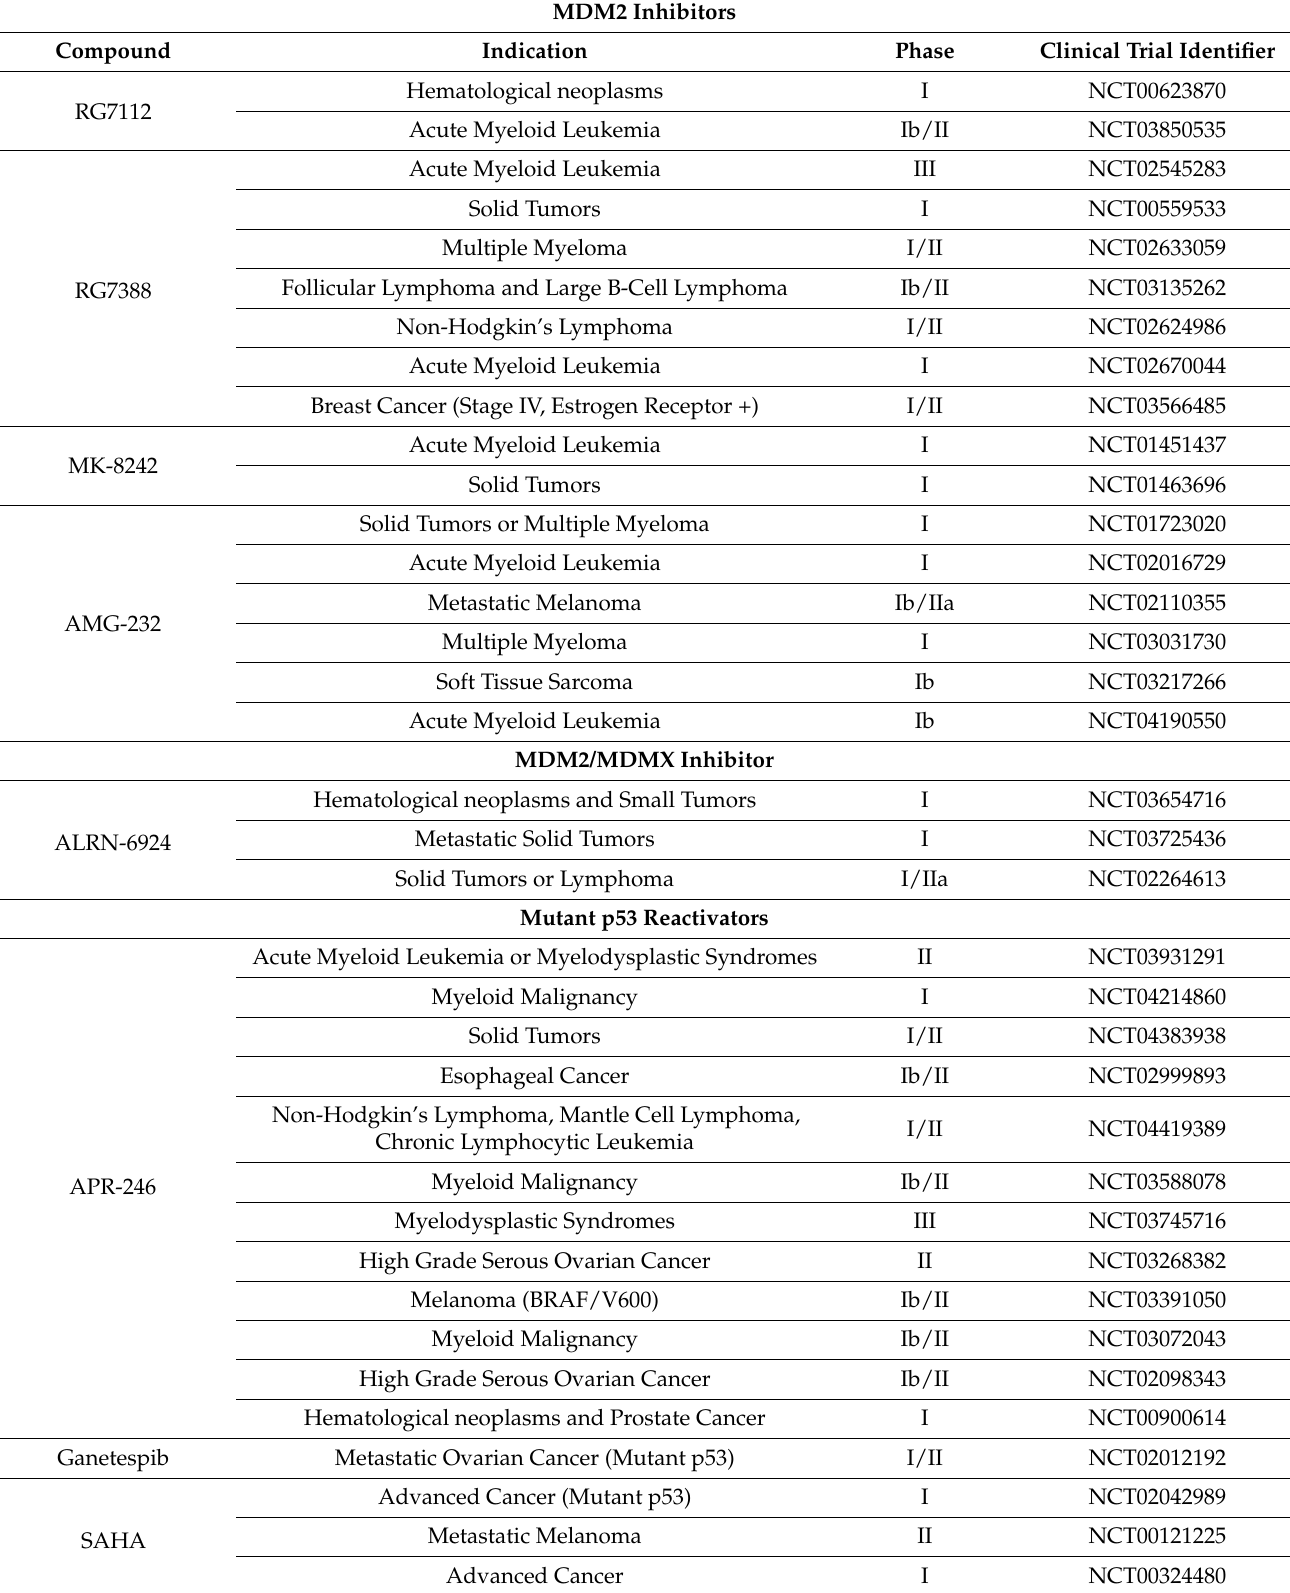
Table 1. Recent clinical